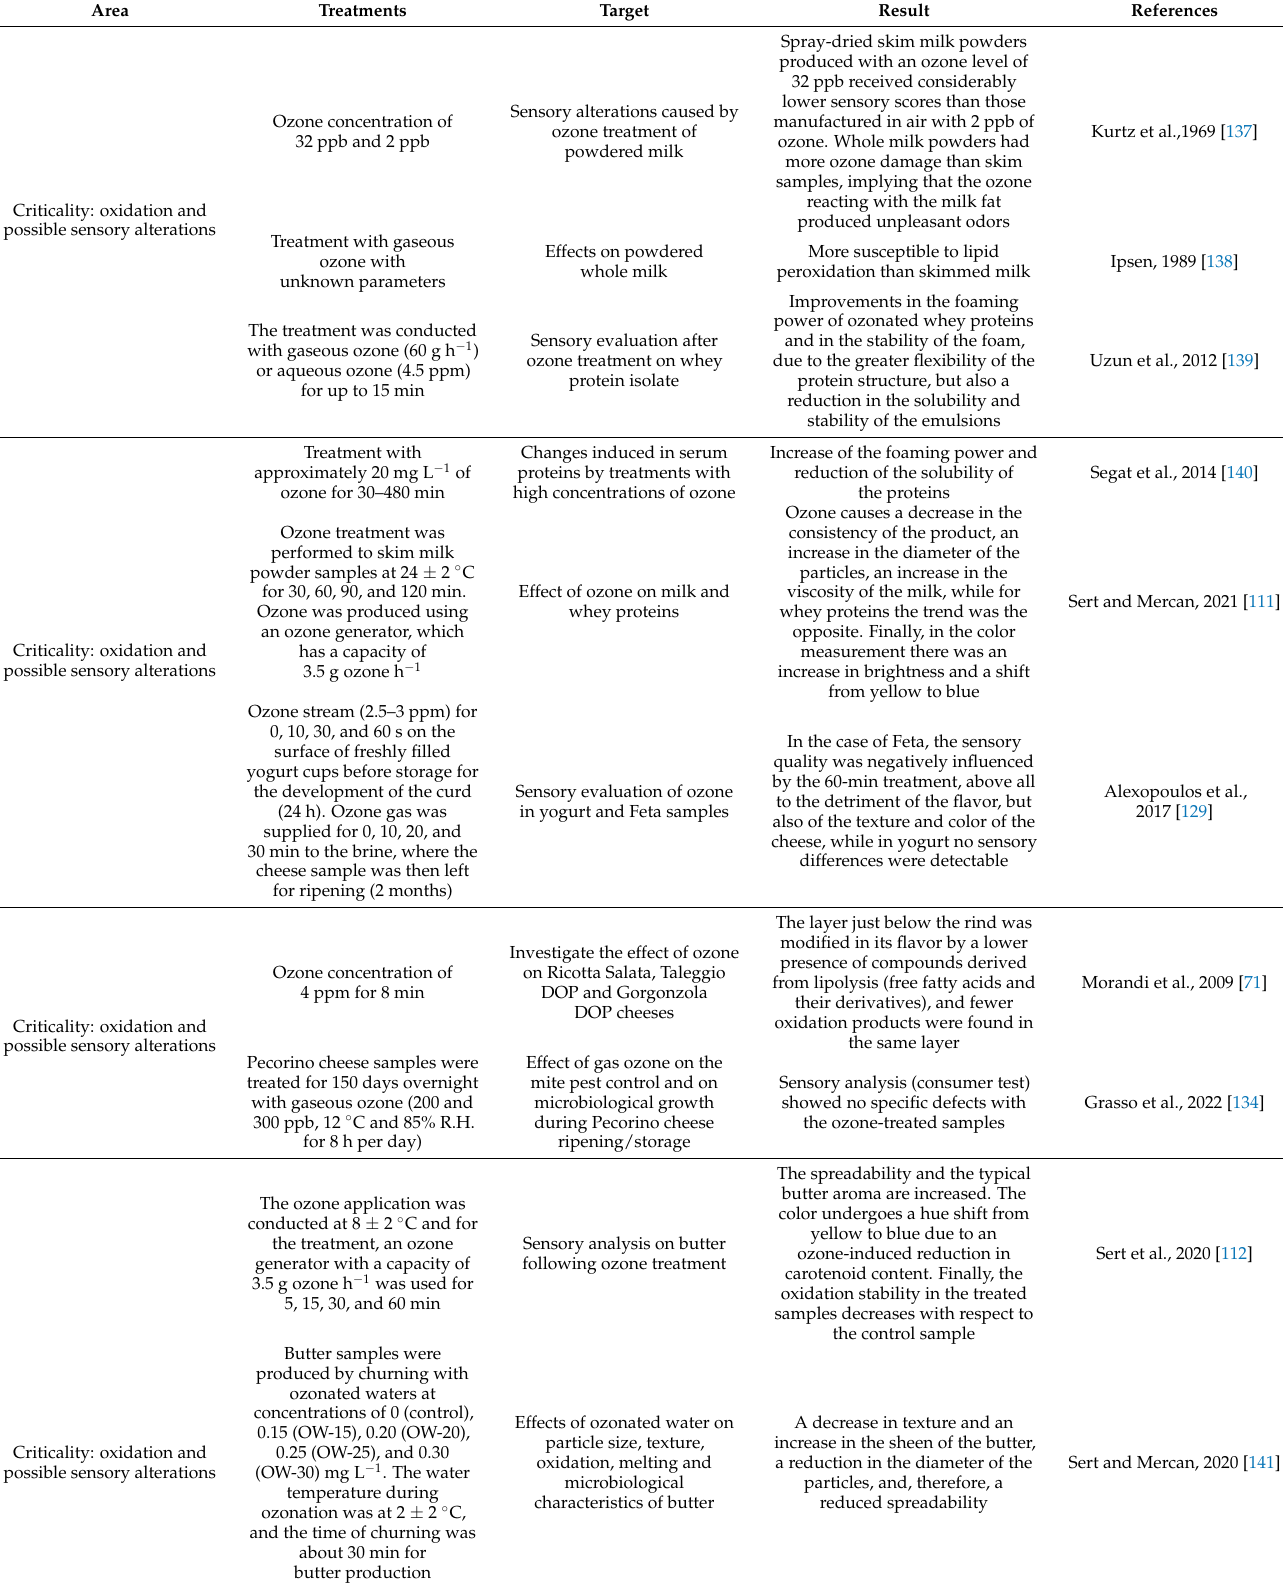
Table 7. Oxidation and possible sensory